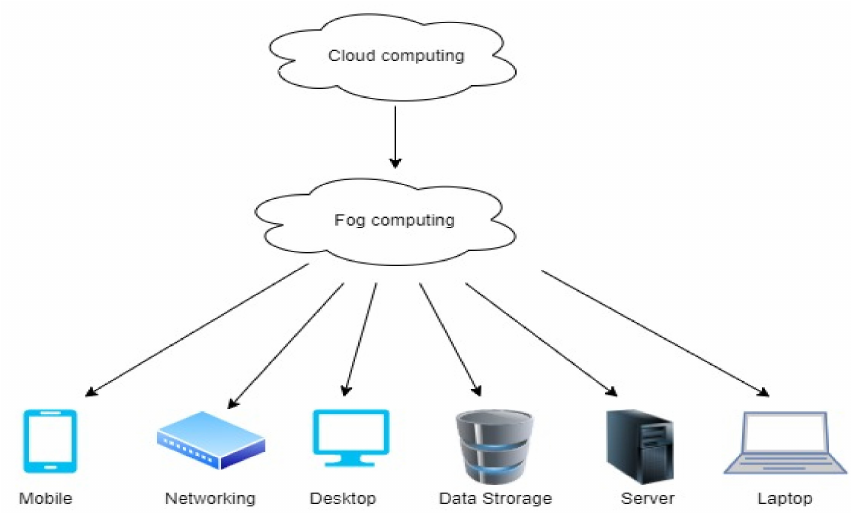
Figure 2. Fog computing platform